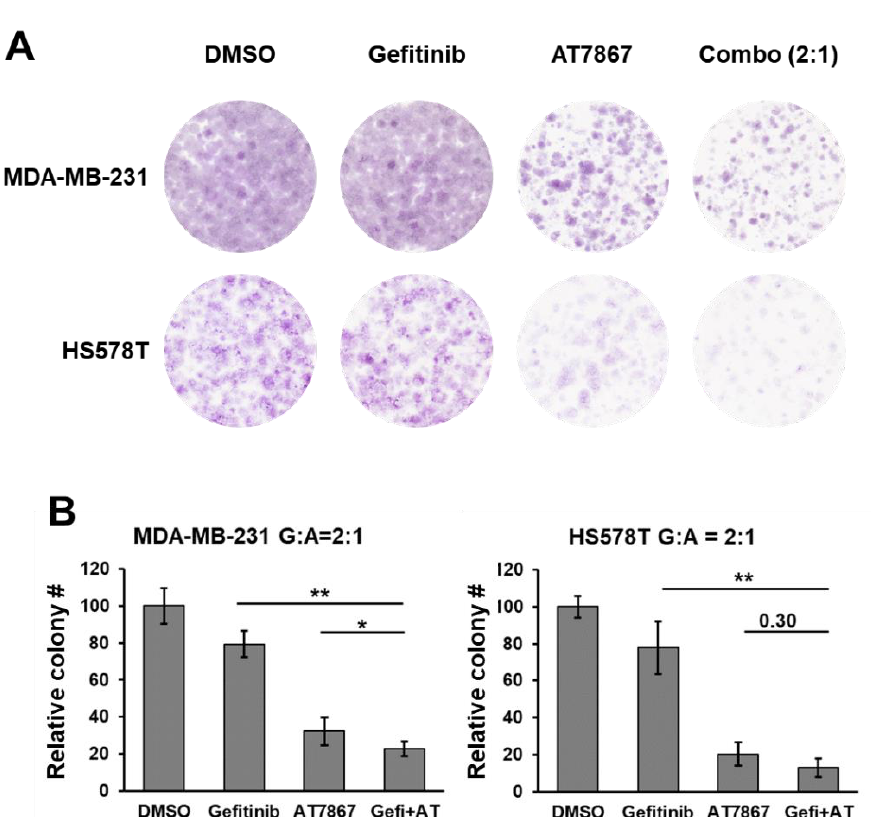
Figure 3. Gefitinib and AT7867 reduced the survival of MSL subtype TNBC cells. ( A ) MDA-MB-231 and HS578T cells were treated with 10 μM Gefitinib, 5 μM AT7867, or 10 μM Gefitinib + 5 μM AT7867 (Gefi+AT) for 24 h in normal growth media. Then, cells were washed and cultivated for additional 10–14 days in normal growth media. The colonies were stained as described in the Materials and Methods. Representative images are shown from three independent experiments performed in triplicate ( B ) The relative colony number was determined and presented as mean ± SEM from three independent experiments performed in triplicate. * p < 0.05 and ** p < 0.01.